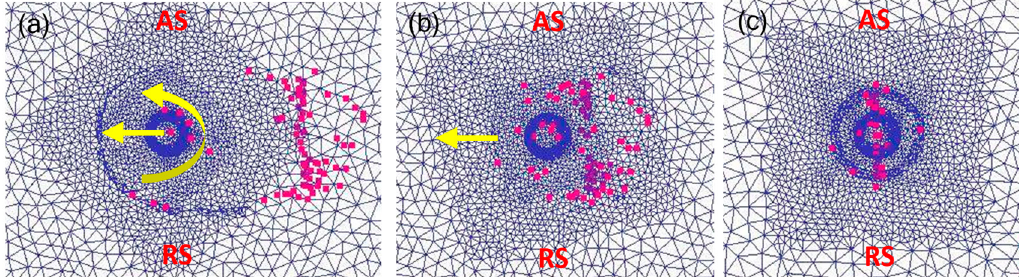
Figure 12. Distribution of tracking particles after welding. ( a ) Cross section distribution perpendicular to welding direction; ( b ) cross section distribution in welding direction.